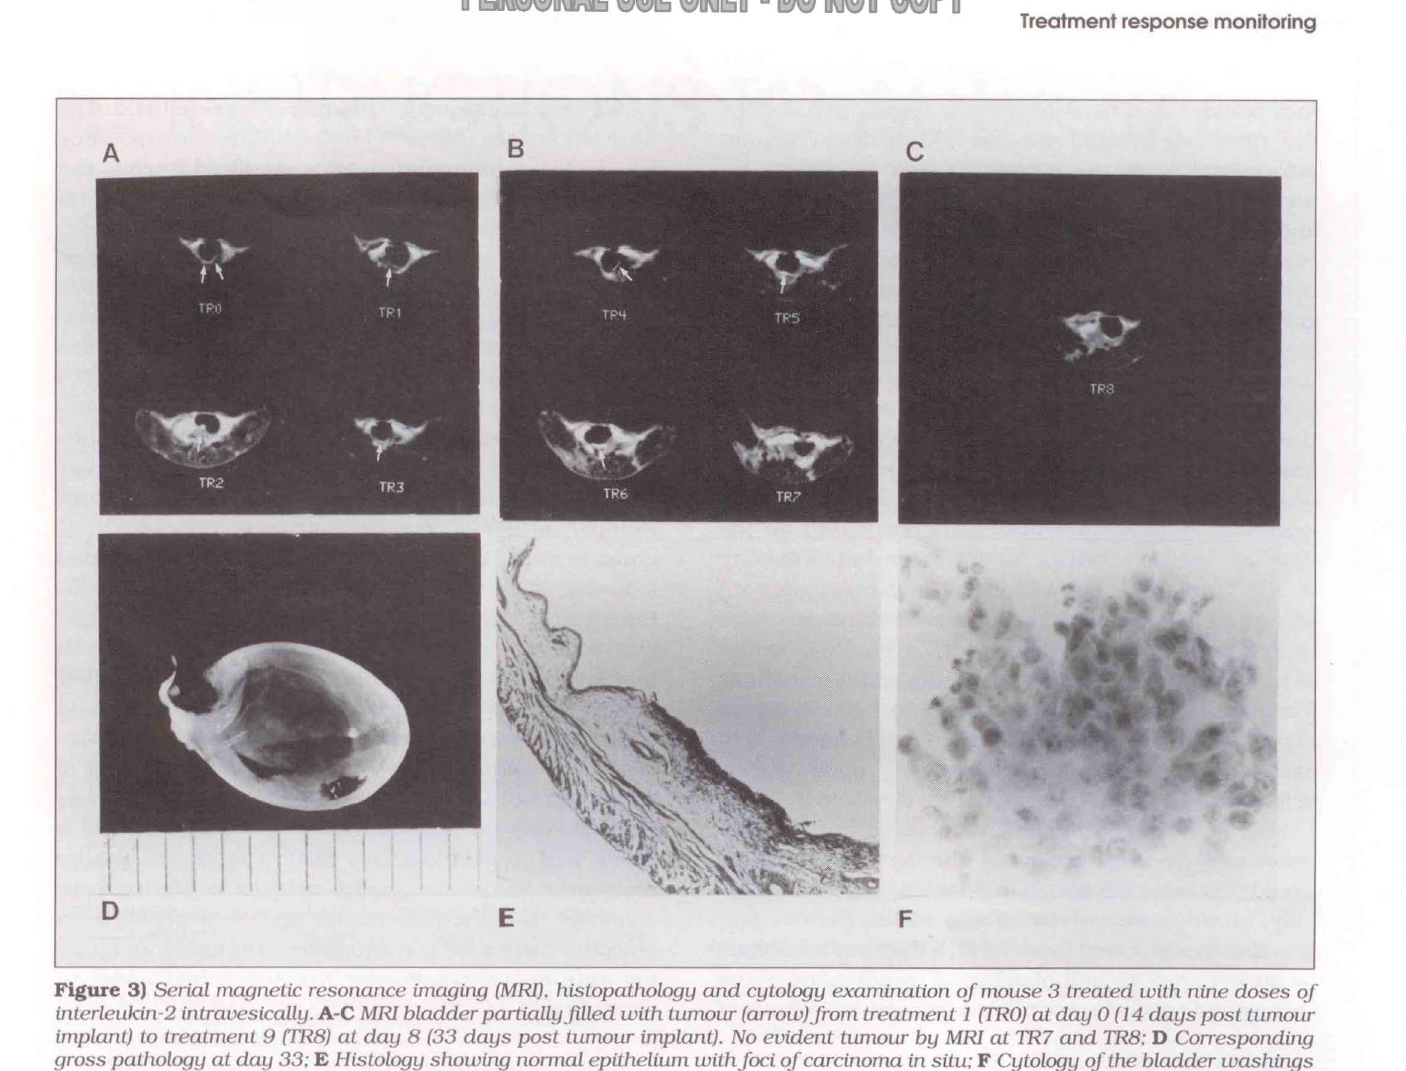
Figure 3) Serial magnetic resonance imaging (MRI). histopathology and cytology examination of mouse 3 treated with nine doses of interleukin-2 intravesically. A-C MRI bladder partially filled with tumour (arrow) from treatment 1 (TRO) at day 0 (14 days post